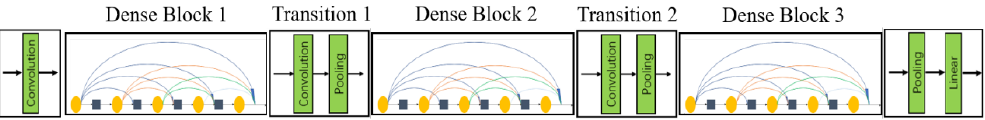
Figure 3. Demonstration of DenseNet structure.